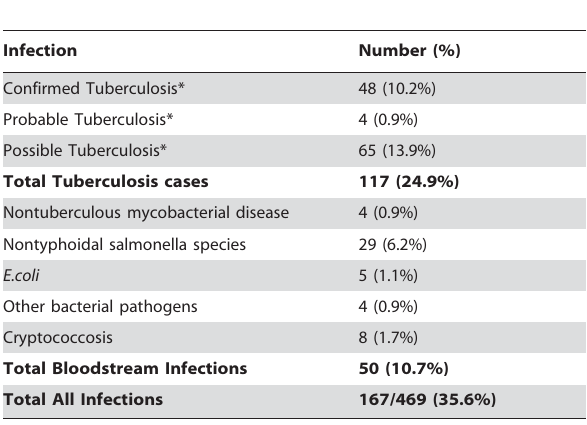
Table 2. Infections diagnosed among 469 study